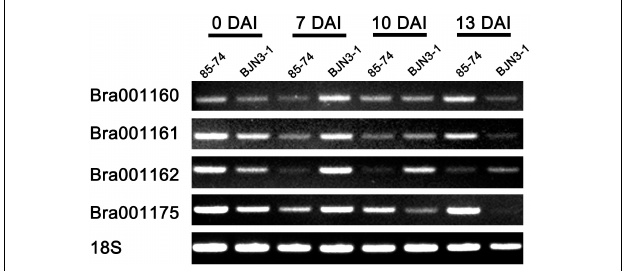
FIGURE 3 | Expression levels of Bra001160, Bra001161, Bra001162, and Bra001175 genes in roots of “85-74” and “BJN3-1.”